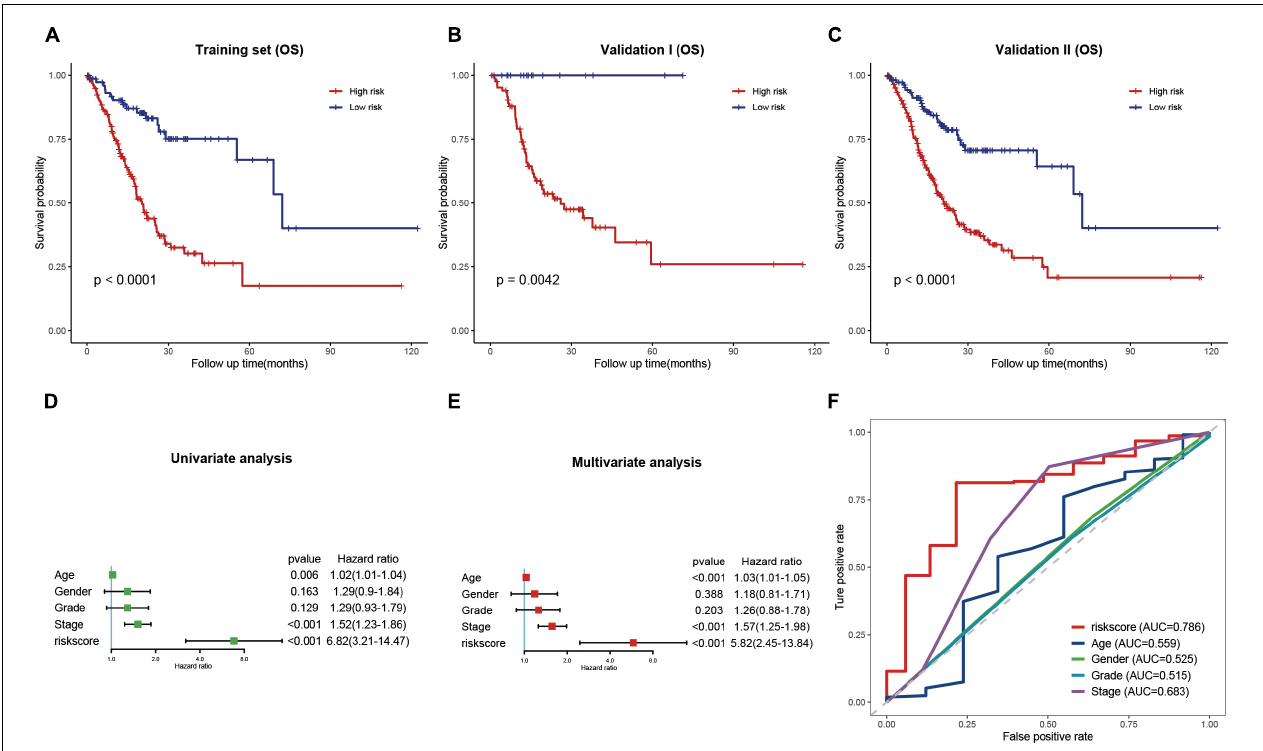
FIGURE 6 | Validation and evaluation of the prognostic signature. (A–C) Kaplan–Meier curves of low- and high-risk groups in the training cohort (A) , validation cohort (B) , and entire cohort (C) . (D,E) Univariate (D) and multivariate (E) Cox regression analysis of the risk score and clinical features. (F) ROC curves of the risk score and traditional clinical